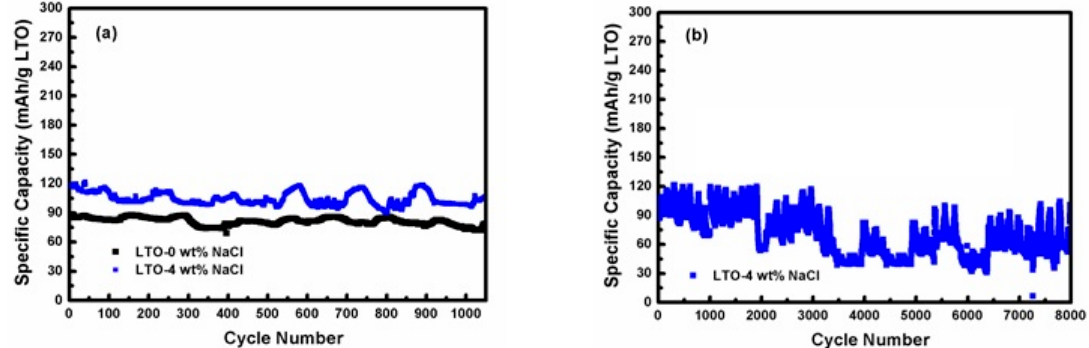
Figure 5. ( a ) Cycle perfomance of LTO material at 10 C-rate; ( b ) Further cycle analysis of LTO-4 wt % NaCl material at 10 C-rate.